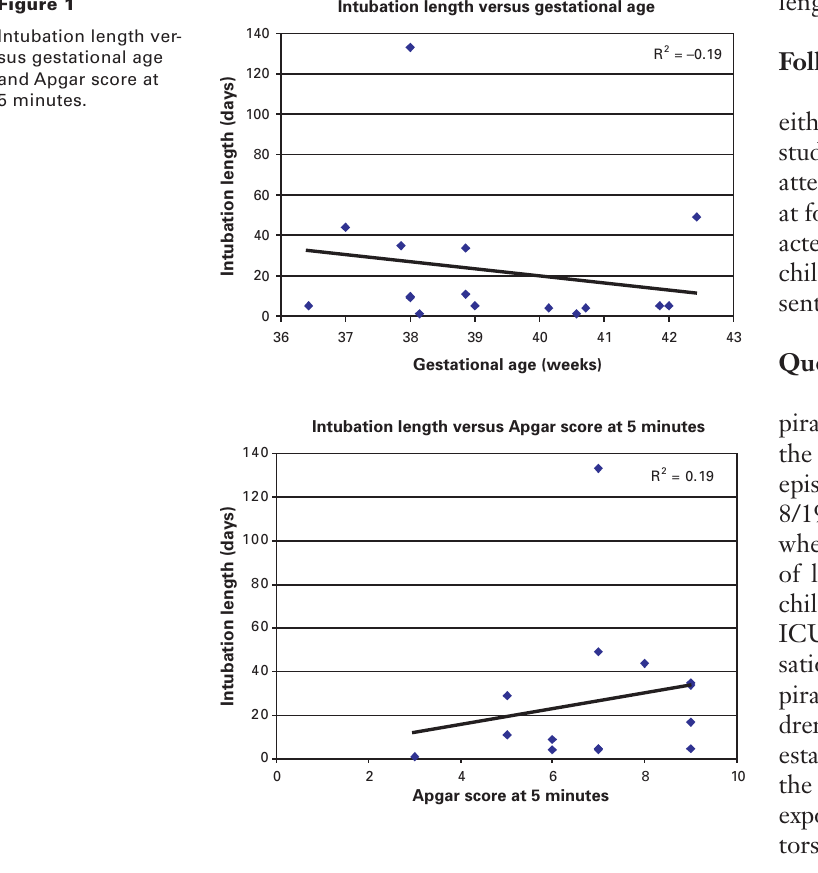
Intubation length ver- sus gestational age and Apgar score at 5